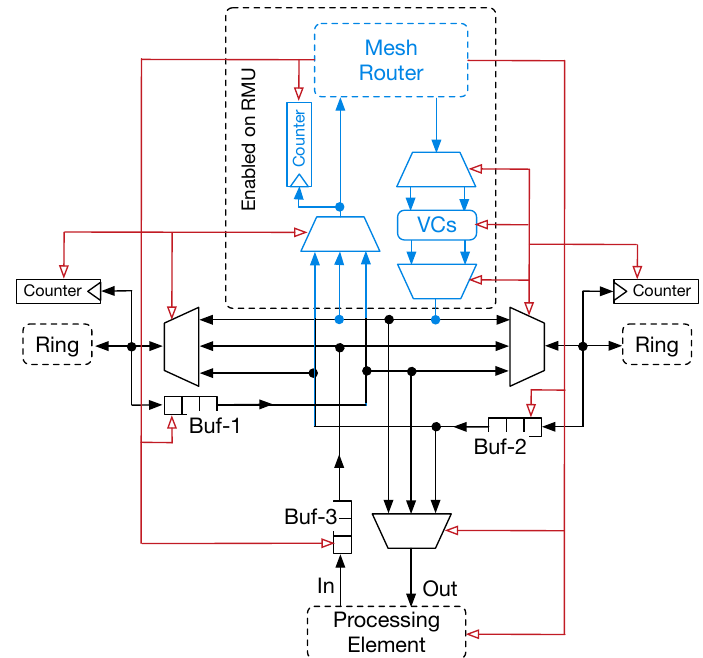
Figure 5. Internal micro-architecture of the ring-switch (RS). The link with the router is enabled only on the ring-master unit (RMU) (blue arrows and blocks). Red arrows represent the power-gating